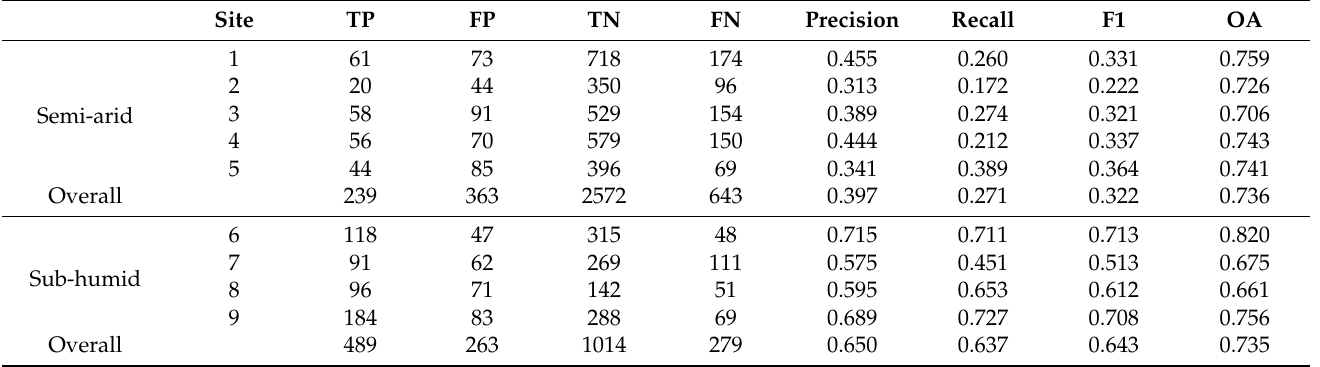
Table 8. Evaluation metrics of olive tree mapping for Planet imagery using LRCN and multiple time